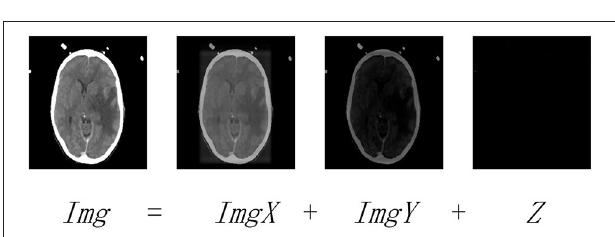
FIGURE 2 | The LatLRR decomposing operation. Img is the observed image. ImgX and ImgY are the low-rank and saliency components of Img , respectively. Z denotes the noisy